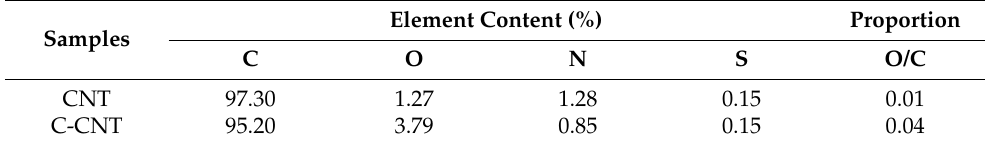
Table 2. Element content of CNT and C-CNT.